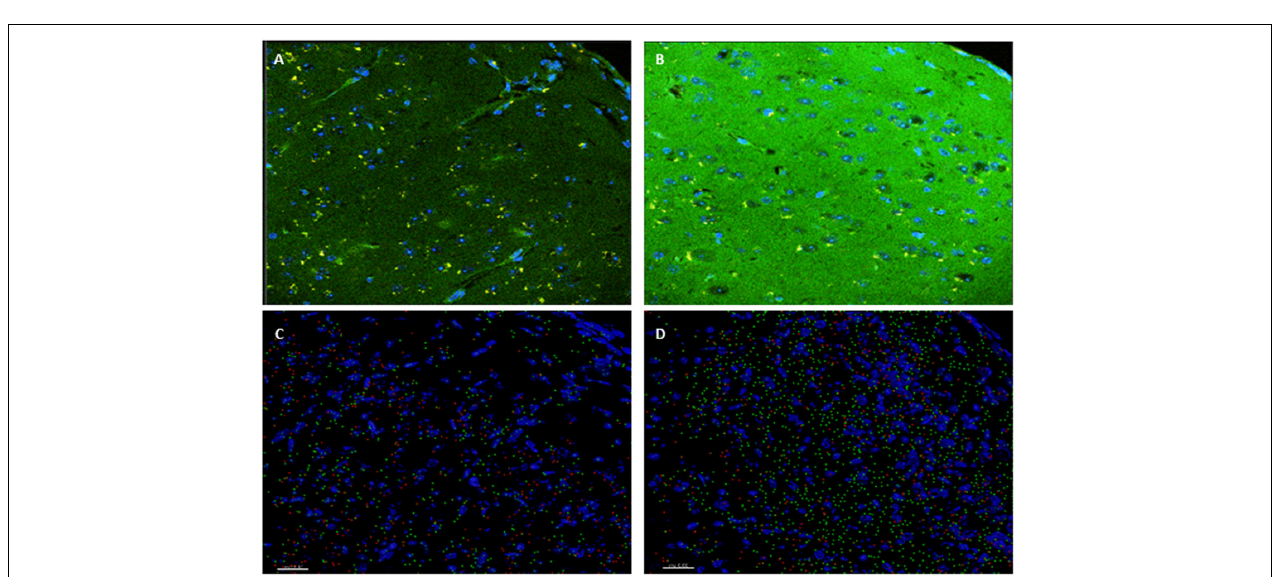
FIGURE 4 | Insulin reduces KA-induced increased in PSDs in PH-Tau-Tg mice. Field potential recordings from prefrontal cortex were filtered at the indicated frequencies and amplified and the respective power spectrum densities are shown above. (A) Represents the power spectrum density of the recording of field potentials obtained from controls ( n = 3) and PH-Tau-Tg mice ( n = 3) in response to addition of KA. (B,C) Represent the power spectrum density of slow ripples (125–250 Hz) and fast ripples (250–500 Hz) obtained from recordings after addition of KA. Insulin significantly reduced the amplitude PSDs for HFOs in the PH-Tau-Tg mice. Data represent means of pooled recordings from controls ( n = 3) and PH-Tg mice ( n = 3) respectively.